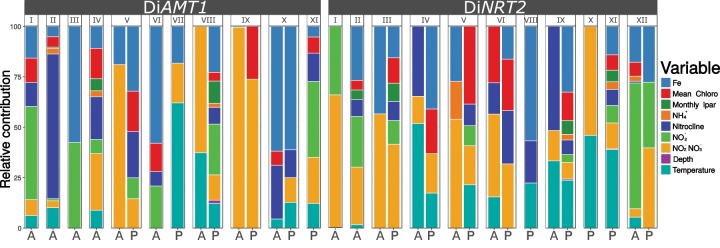
Relative contributions of the nine environmental predictors selected for the BRT modeling. Contribution is expressed as number of times a variable is selected for splitting the regression trees branches, weighted by the squared improvement to the model as a result of each split, averaged over all trees and scaled to 100. This information is expressed both for models based on presence–absence (P) and on mRNA abundance data on the 20–180 µm size fraction (A).